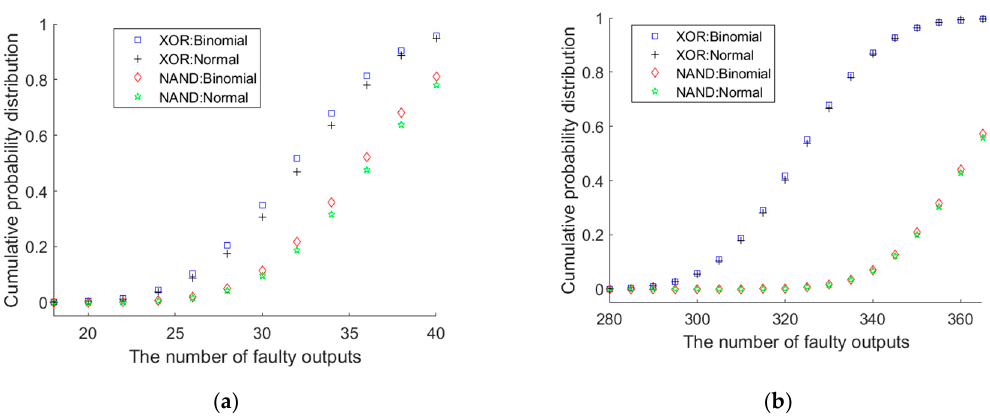
Figure 3. The cumulative error distributions of the XOR multiplexing unit and the NAND multiplexing unit: ( a ) N = 100; ( b ) N = 1000.